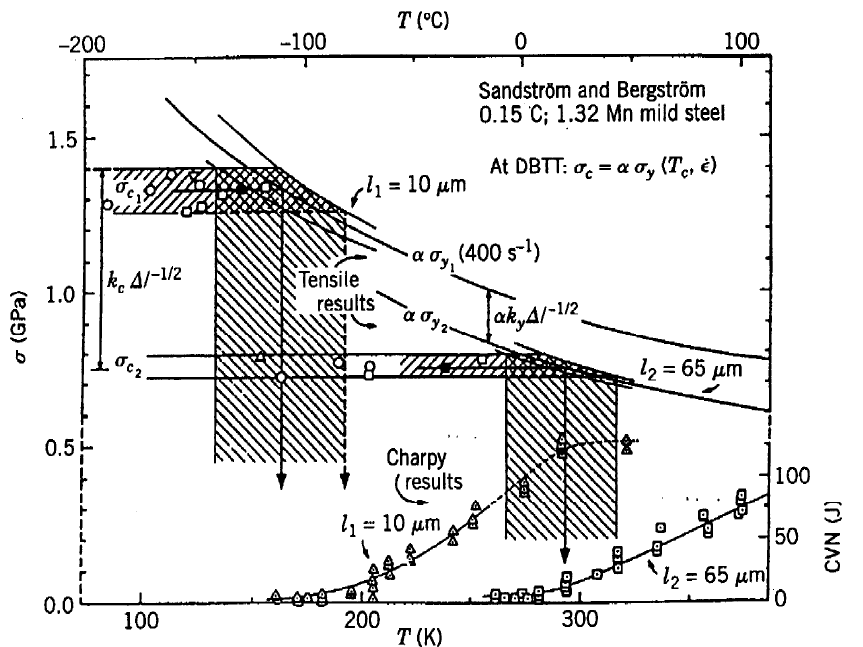
Figure 4. A compilation of tensile test and Charpy impact test results obtained by Sandström and Bergström in determining a ductile-to-brittle transition in behavior at two grain sizes [14,15].